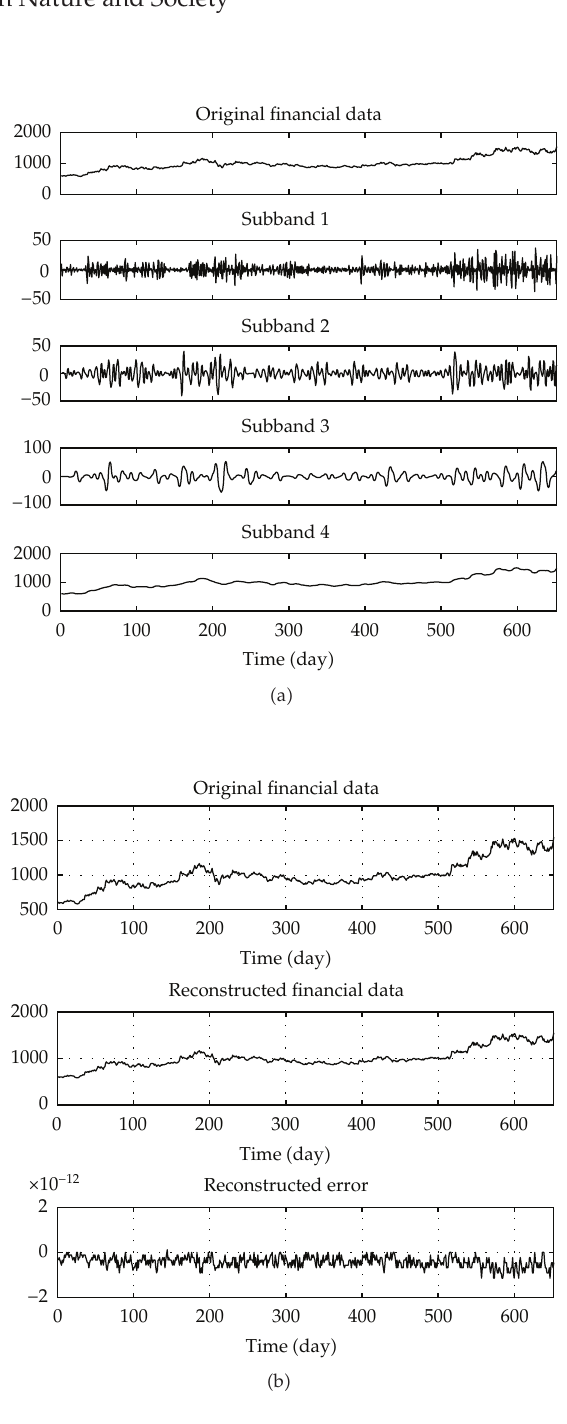
Figure 2: (cid:2) a (cid:3) Wavelet decomposition of financial data into four subbands. (cid:2) b (cid:3) Original financial data for channel 1 (cid:2) top (cid:3) , reconstructed data by simply adding the subbands (cid:2) middle (cid:3) and reconstruction error (cid:2) bottom (cid:3) . The SNR of the reconstructed signal is